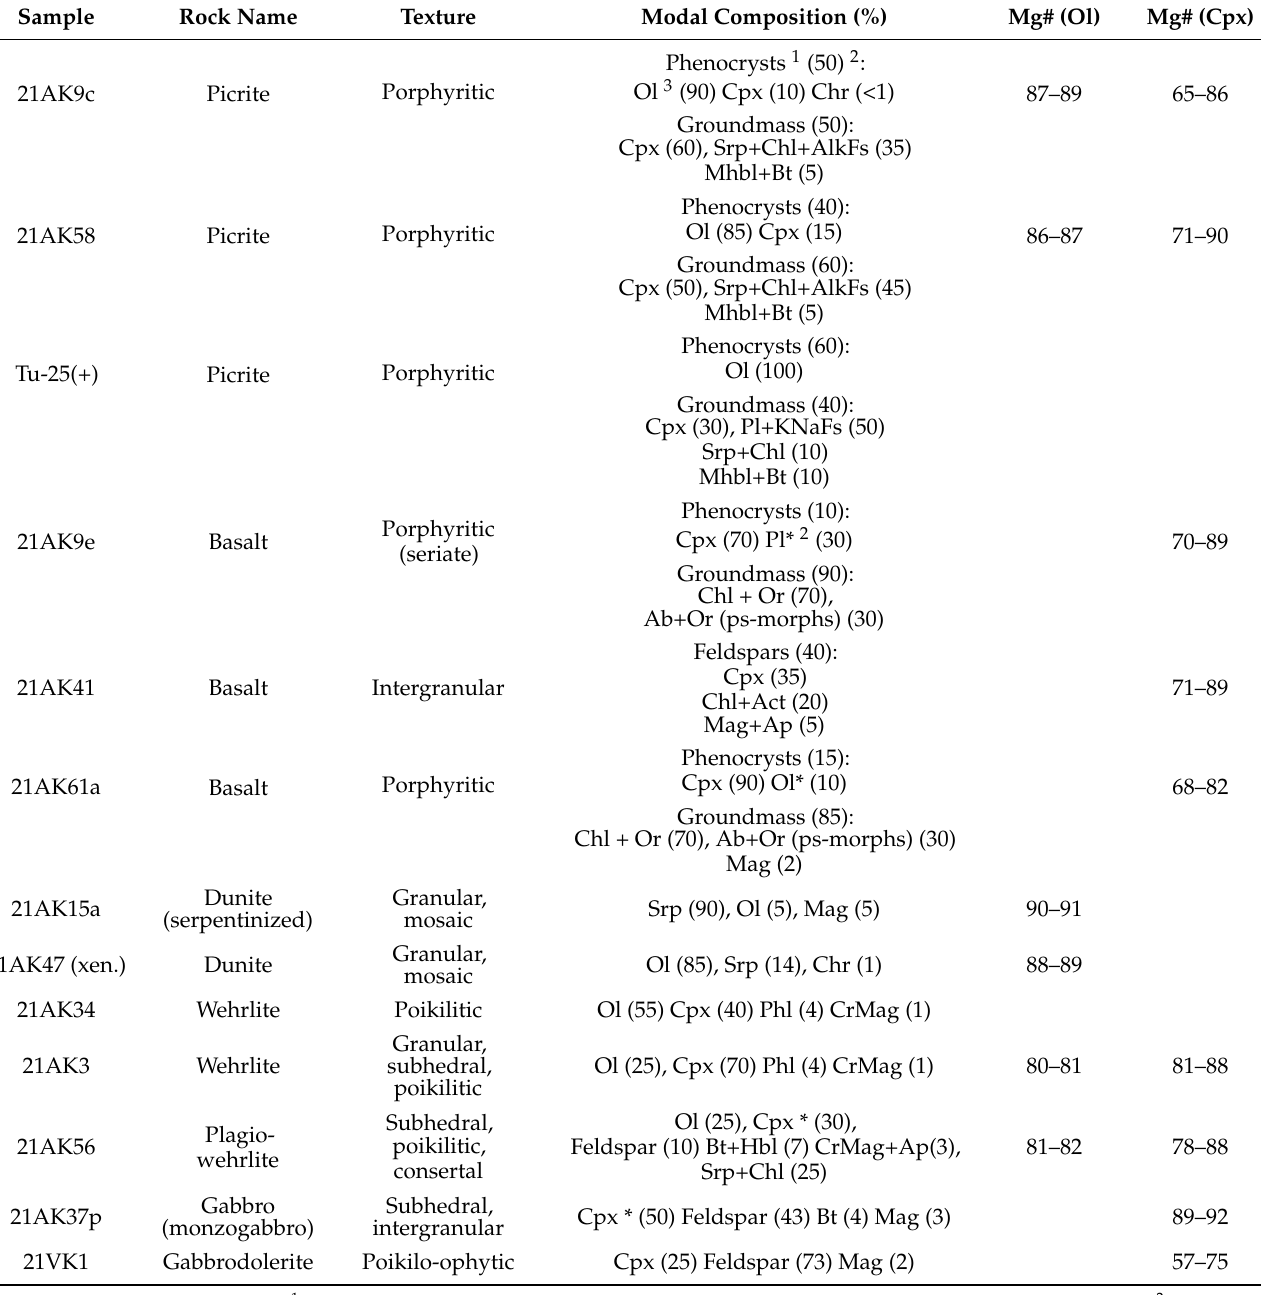
Table 1. Petrographical and mineralogical summary of the main samples